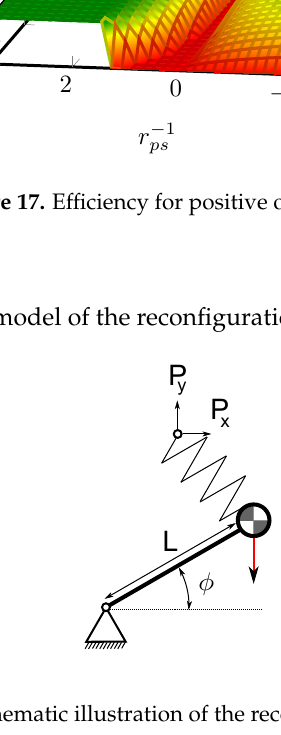
Figure 18. Schematic illustration of the reconfiguration